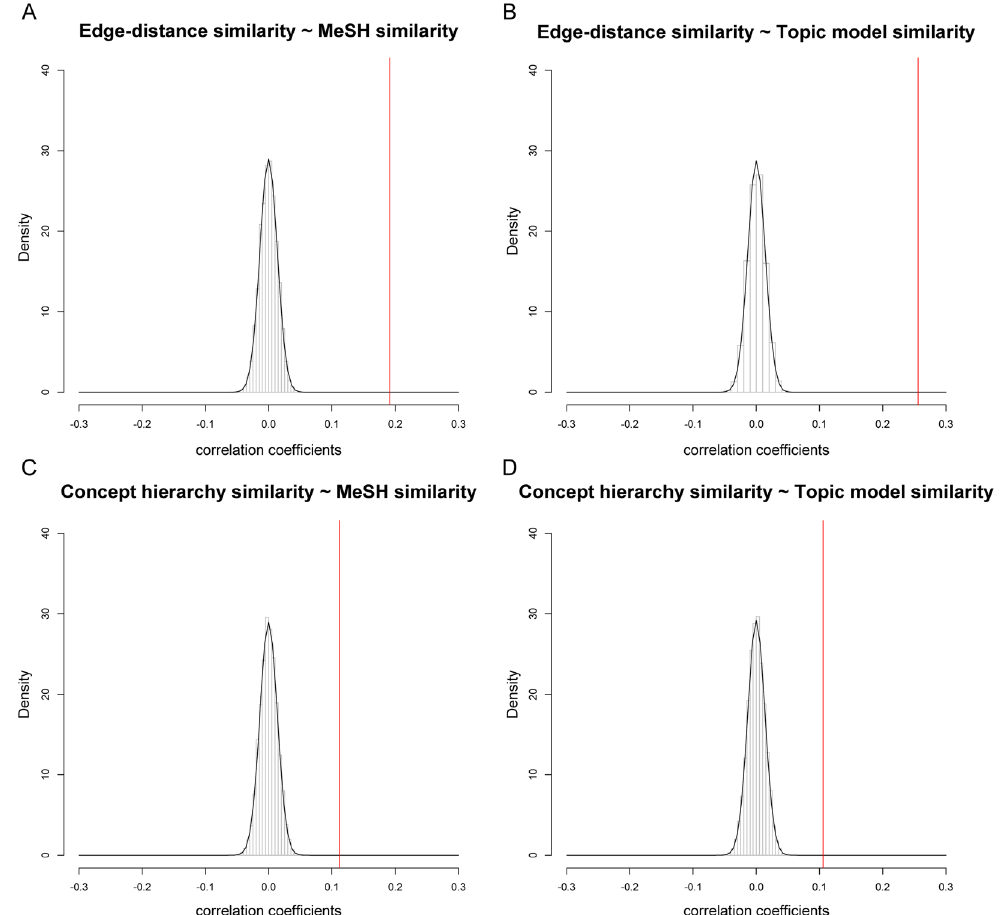
Figure 5. The correlation coefficient of anatomical and functional similarity relative to a null distribution. ( A ) The correlation between the anatomical similarity as defined by the edge-distance and MeSH similarity is 13.8SD removed from the null distribution. ( B ) The correlation between the anatomical similarity as defined by the edge-distance and Topic model similarity is 18.6SD removed from the null distribution. ( C ) The correlation between the anatomical similarity as defined by the concept hierarchy and MeSH similarity is 8.1SD removed from the null distribution. ( D ) The correlation between the anatomical similarity as defined by the edge-distance and probability topic model similarity is 7.6SD removed from the null distribution. The red line indicates the true correlation coefficient between the anatomical and functional